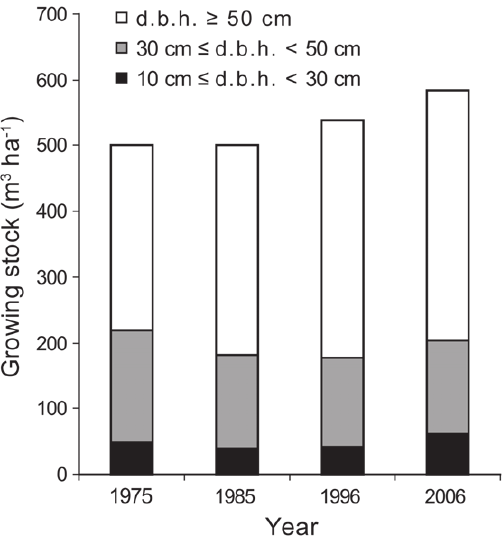
Figure 9. Distribution of growing stock in three d.b.h. classes in the Kopa forest